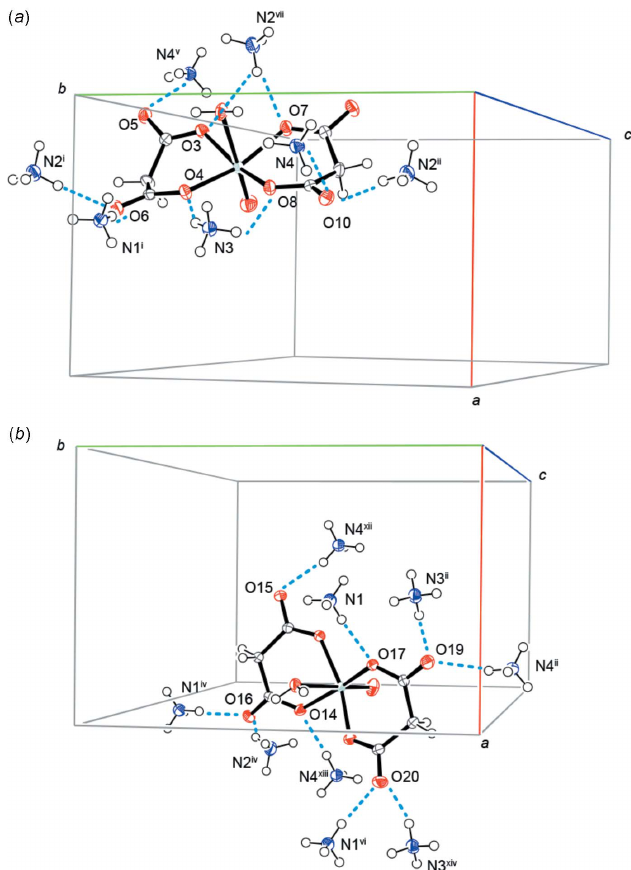
Figure 2 Packing diagrams showing N—H (cid:2)(cid:2)(cid:2) O hydrogen bonds (blue dashed lines) ( a ) between the syn isomer and adjacent cations and ( b ) between the anti isomer and adjacent cations. Displacement ellipsoids are drawn at the 50% probability level. [Symmetry codes: (i) (cid:3) x + 1, y + 1 , (cid:3) z + 1 ; (ii) 2 2 (cid:3) x + 1, y (cid:3) 1 , (cid:3) z + 1 ; (iv) x + 1 , (cid:3) y + 3 , (cid:3) z + 1; (v) (cid:3) x , y + 1 , (cid:3) z + 1 ; (vi) 2 2 2 2 2 2 x + 1, y , z ; (vii) x (cid:3) 1, y , z ; (xii) (cid:3) x + 1 , (cid:3) y + 1, (cid:3) z + 1 ; (xiii) (cid:3) x + 3 , (cid:3) y + 1, 2 2 2 (cid:3) z + 1 ; (xiv) (cid:3) x + 2, y (cid:3) 1 , (cid:3) z + 1 2 2 2